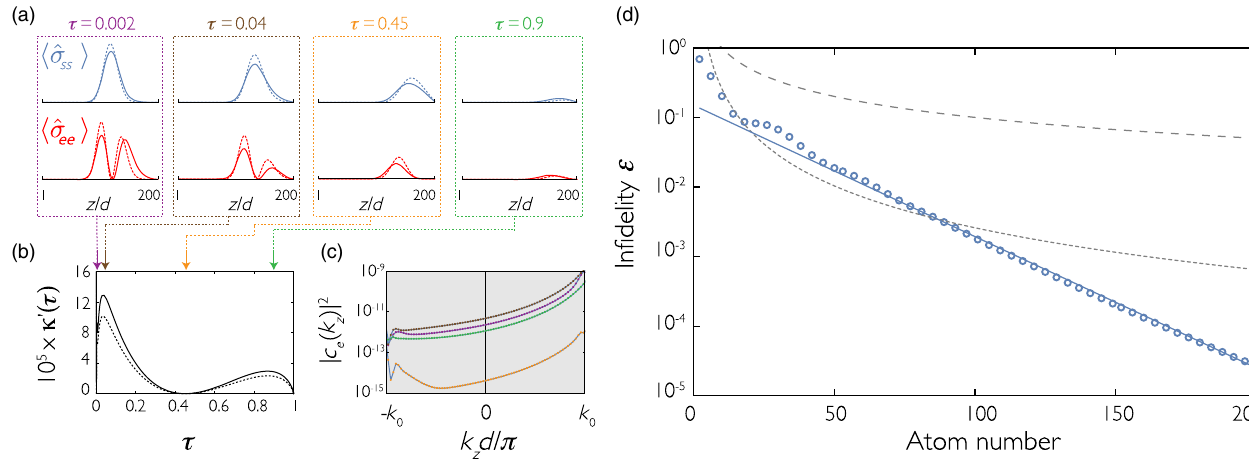
ffiffiffiffiffiffiffiffiffiffiffiffiffiffiffiffiffiffiffiffiffiffiffiffiffiffiffiffiffi p 0 . 005 Γ z N= ð N þ 1 − j Þ 0 . In (a), the dotted c ð j Þ ¼